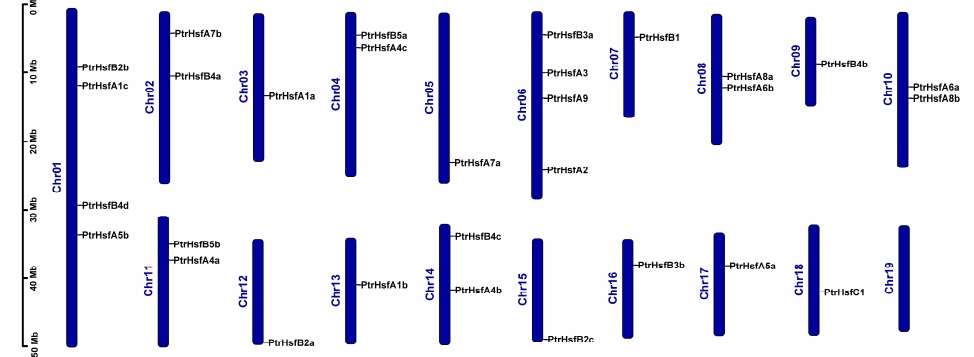
Figure 5. Chromosomal distribution and tandem duplication events identification of poplar HSF genes. No tandem duplication event occurred between genes. Subsequently, tandem duplication events between the genes were analyzed using TBtools and MCScanX [34,44]. Notably, no tandem duplication event existed among the poplar HSF genes (Figure 5). Then, we explored the segmental duplication events between genes. The results showed that a total of 14 pairs of poplar HSF genes possessed segmental duplication events, involving 15 chromosomes of poplar (Figure 6, Table S4). The above analysis results indicated that segmental duplication events might be one of the main rea- sons for the expansion of the poplar HSF gene family.